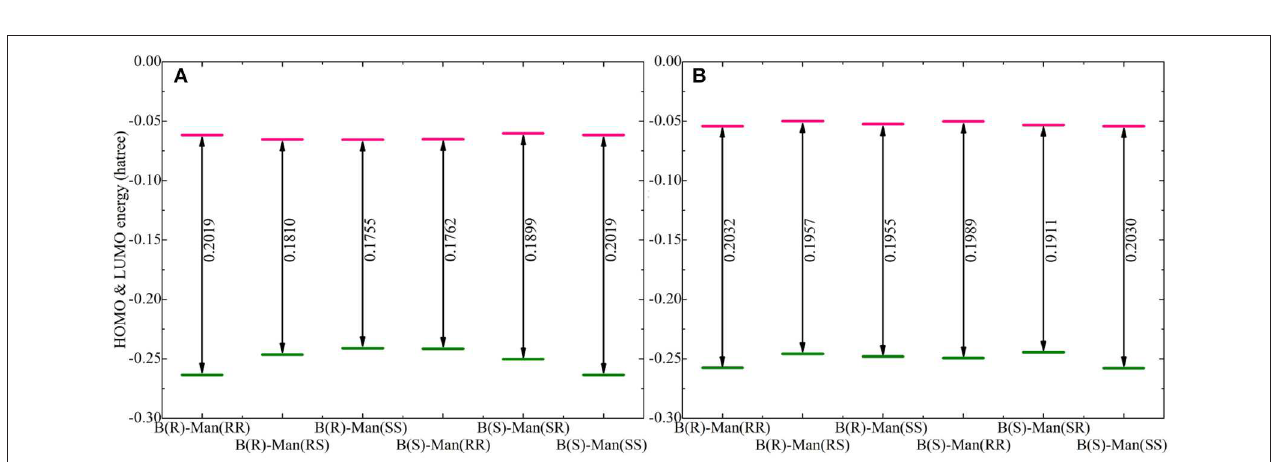
FIGURE 7 | HOMO (lower panels) and LUMO (upper panels) contours for the optimized Li[BMB] ion-pair structures with anions of varied molecular chiralities. These orbital isosurfaces were drawn with a contour value of 0.02. The purple and green isosurfaces of HOMO and LUMO indicate negative and positive values, respectively. The hydrogen, boron, carbon, and oxygen atoms in [BMB] anions are represented by white, yellow, cyan, and red spheres, respectively, and Li + ions are represented by green spheres. (A) B(R)-Man(RR), (B) B(R)-Man(RS), (C) B(R)-Man(SS), (D) B(S)-Man(RR), (E) B(S)-Man(SR), and (F) B(S)-Man(SS).